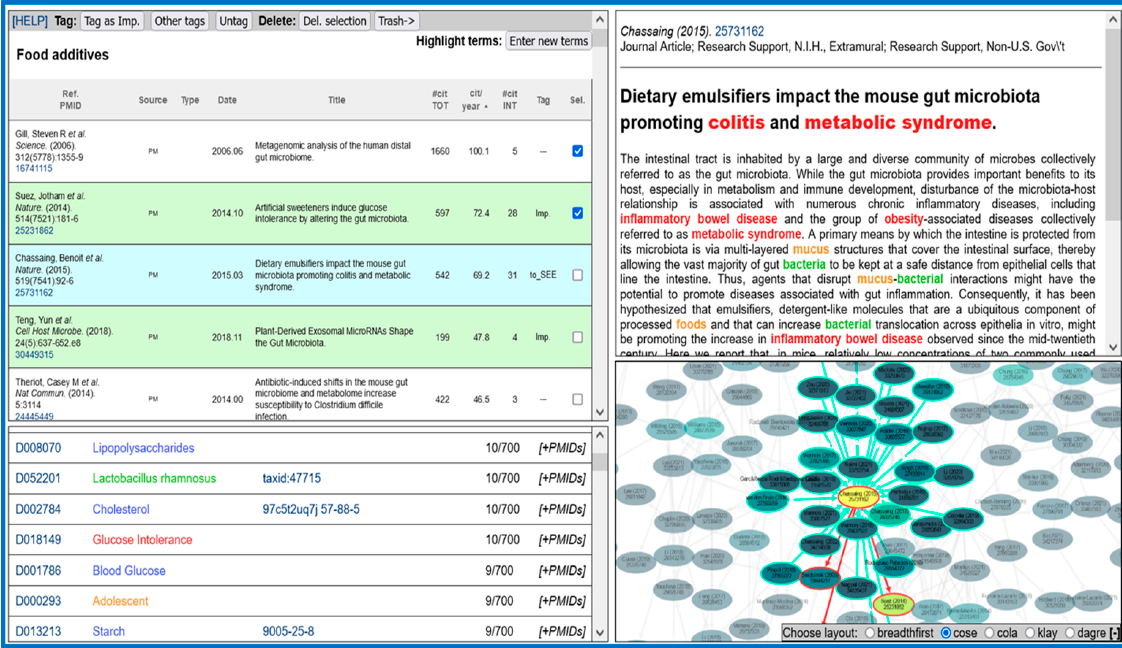
Figure 2. Screenshot of a PMIDigest interactive web report. The four main panels are: a table with the list of articles ( top left ), a table with MeSH terms ( bottom left ), the citation network ( bottom right ), and article details ( top right ). In this example, MeSH terms related to diseases are colored red; those describing microorganisms are indicated in green; those related to chemical and biological compounds are indicated in blue; and those associated with food, body parts/substances, and age are indicated in orange. The selected article is highlighted in the article list (light-blue background) and the citation network (with the incoming citations shown as light-blue arrows and the outgoing citations as red arrows), and its details (including the abstract) are shown in the top-right panel. The interactive report for this example is available at https://csbg.cnb.csic.es/jnovoa/PMIDigest/ example/FoodAdditives.html, accessed on 13 March